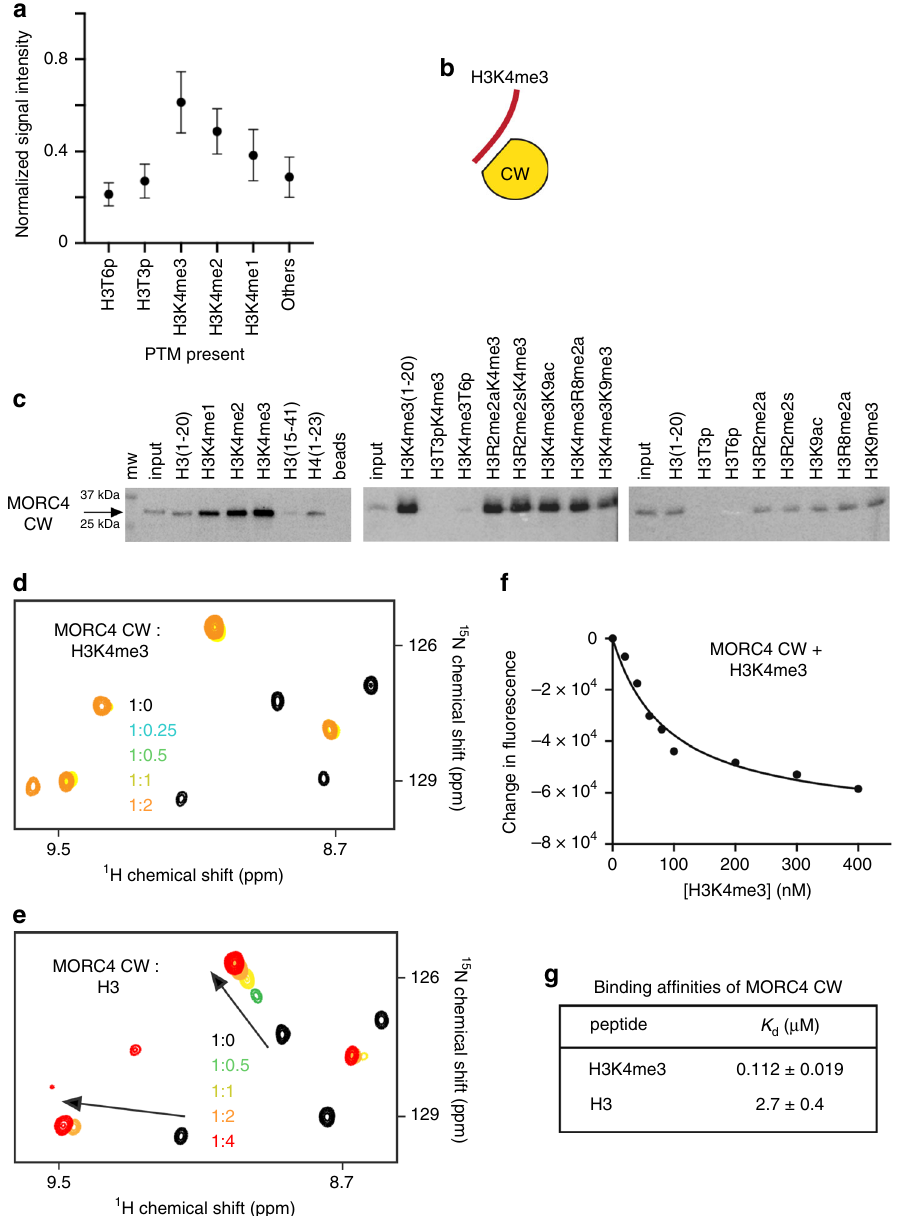
Fig. 2 The CW domain of MORC4 recognizes H3K4me3. a Normalized average microarray signal intensities detected upon binding of the GST-tagged MORC4 CW domain to the peptides carrying indicated PTMs. Data are represented as mean values + / − S.D. from n ≥ 3 independent arrays. See also Supplementary Data 1. b Cartoon representation of CW in complex with histone H3K4me3 tail. c Peptide pull-down assays of the GST-tagged MORC4 CW domain using the indicated histone H3 peptides. Images are representative of three independent experiments with similar results ( n = 3). Source data